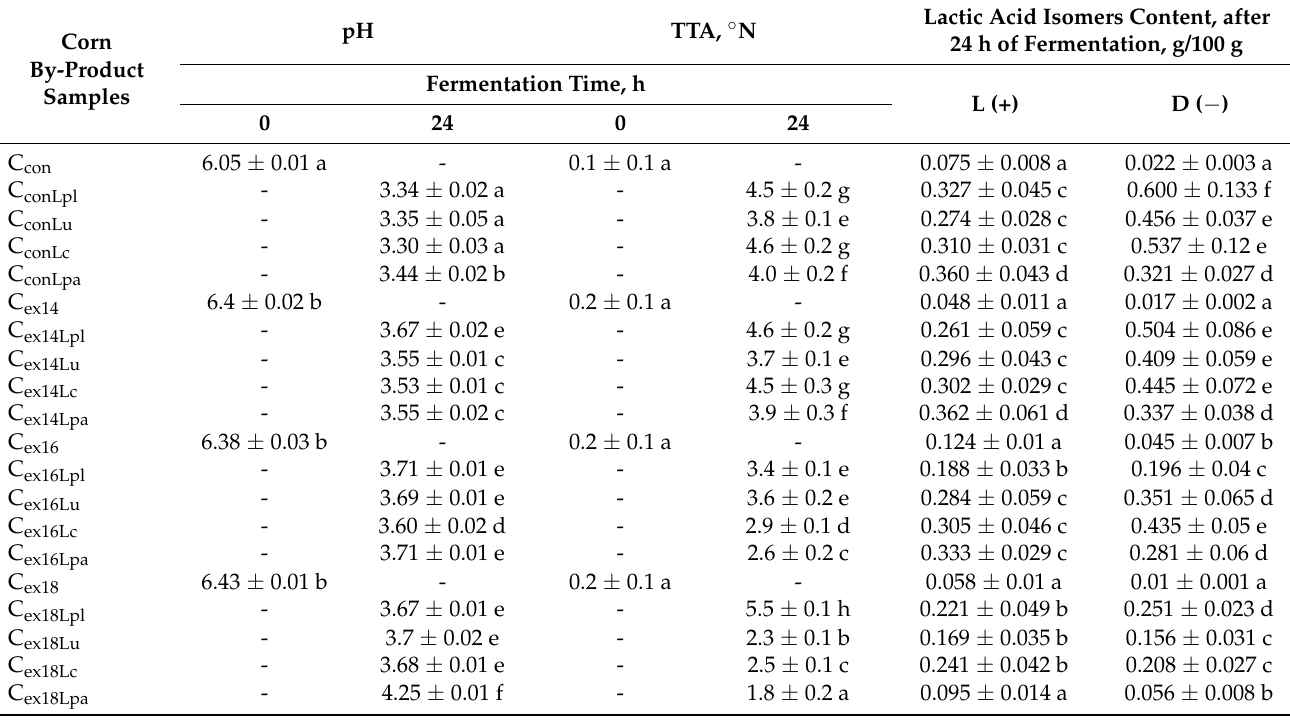
Table 1. Acidity parameters of non-treated and treated corn